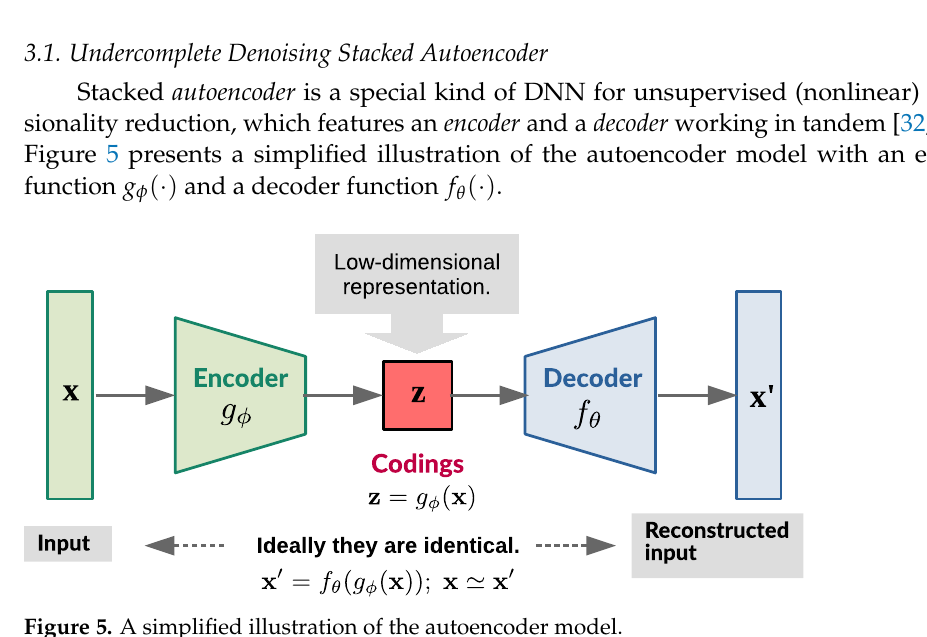
f θ ( · ) are, essentially, two mirror–image DNNs, graphically presented in Figure 6.